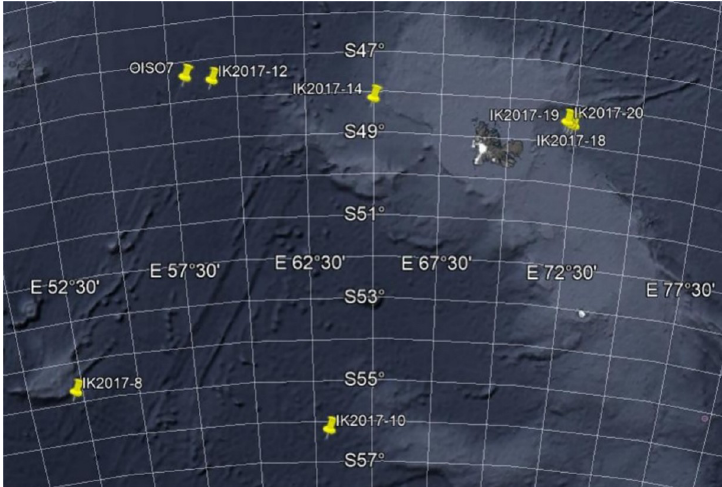
Fig 1. Sampling sites near Kerguelen. Crozet islands are located on the west, not visible. Map obtained using Google Earth.